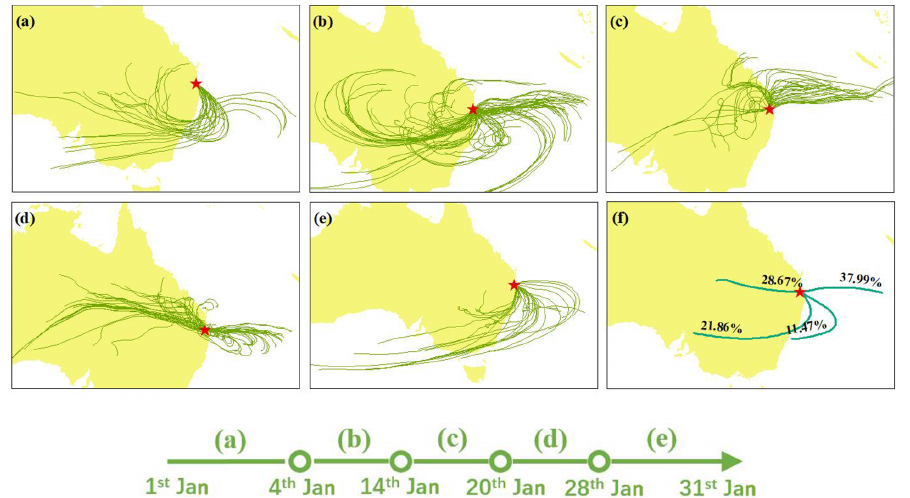
Figure 16. The site’s wind backward trajectories at 3km during January 2020. The wind backward trajectories during the first no-SLB period from 1 to 3 January (a) , the wind backward trajectories during the second no-SLB period from 5 to 13 January (b) , the wind backward trajectories during the third no-SLB period from 15 to 19 January (c) , the wind backward trajectories during the fourth no-SLB period from 21 to 27 January (d) , the wind backward trajectories during the fifth no-SLB period from 29 to 31 January (e) and the contribution of the four main wind clusters based on the wind backward trajectories during the whole month of January 2020 (f) .